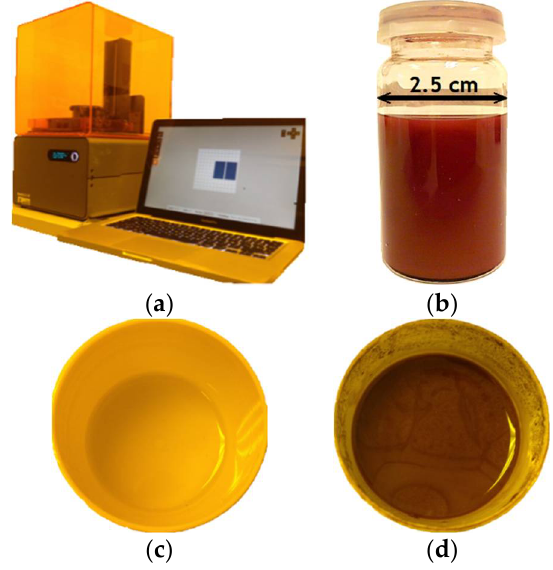
Figure 2. ( a ) Form 1+ printer. ( b ) Cu NWs in IPA. Resin types used in the substrates manufacturing. ( c ) Resin without Cu NWs and ( d ) Resin mixed with Cu NWs at 10.0% w / w . Table 1. Mass measurements of the Cu NWs and mixture and manufacturing features.